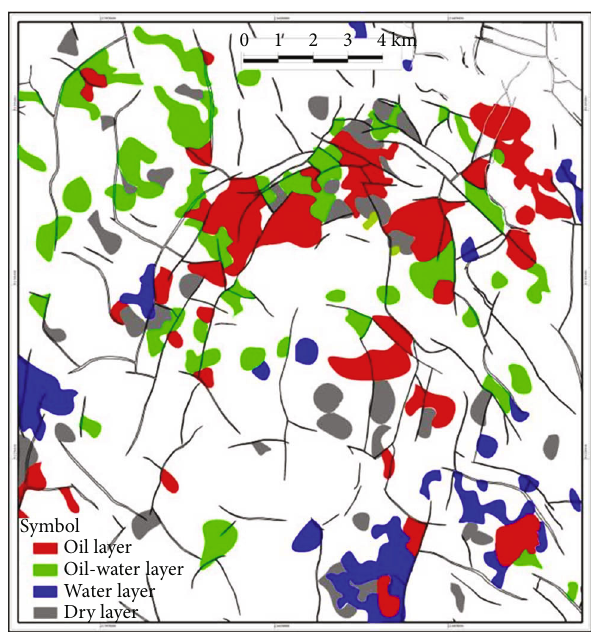
Figure 4: Lower of oil and water distribution in Portugal